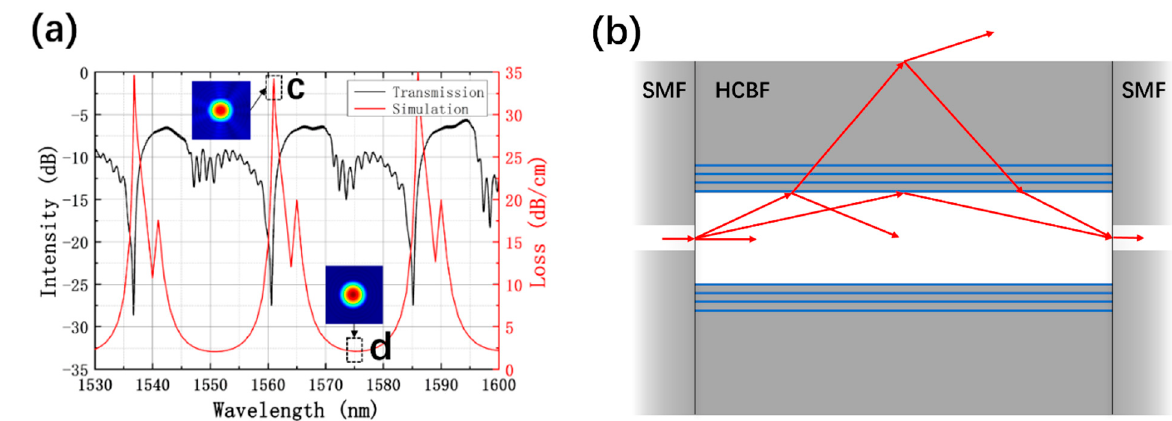
Figure 3. ( a ) Experimental transmission spectrum of the HCBF-based sensor (black curve) and simulation transmission loss spectrum of the HCBF (red curve), insets show the simulated mode profiles at the wavelength of 1561 nm (peak c) and 1575 nm (peak d); ( b ) schematic diagram of the guiding mechanism of the HCBF-based sensor.